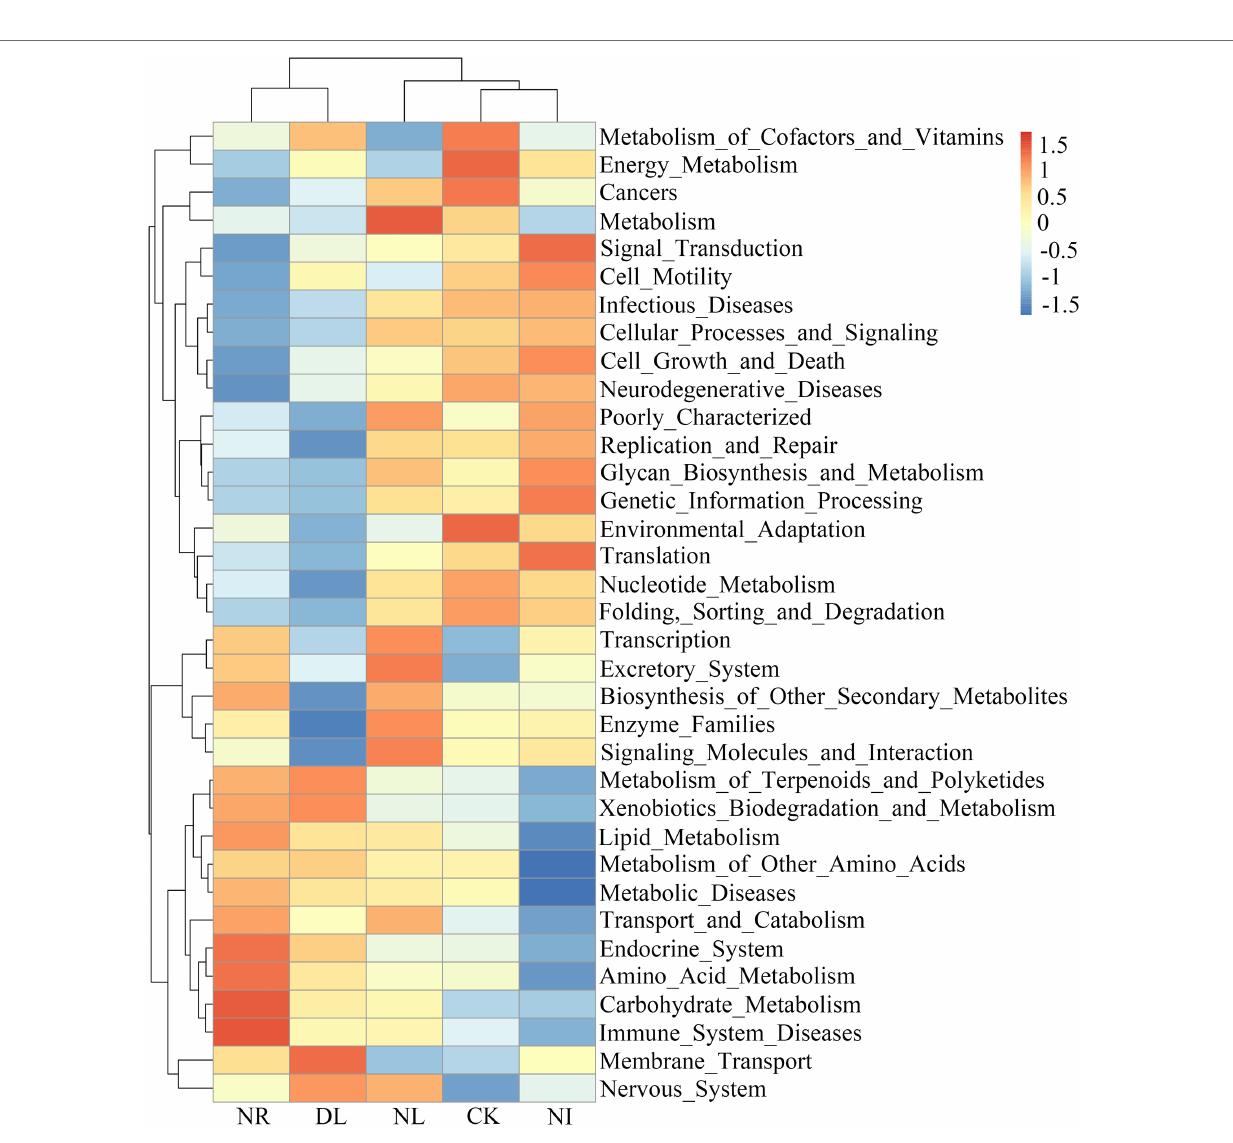
( Figure 8A ). The Monte Carlo permutation test showed that soil organic C ( F = 2.5, p = 0.038) was the main factor that drove changes in dominant phyla in the bacterial community ( Table 1 ).